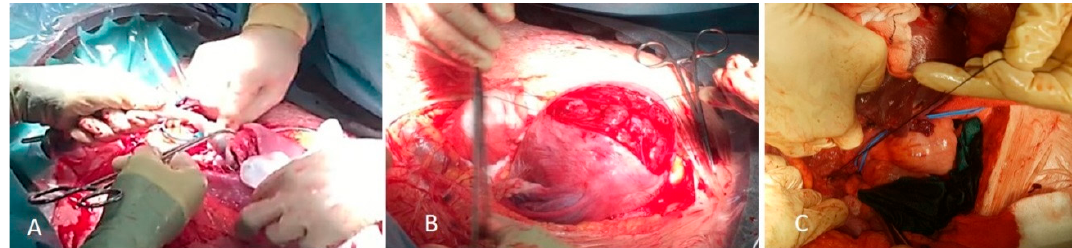
Figure 3. Cesarean section. ( A ) Fundal incision for fetal extraction. Cord clamping, leaving placenta in situ. ( B ) Histerotomy closure, leaving placenta inside the uterus. ( C ) Left hypogastric artery ligation. Left ureter is identified (blue marker).